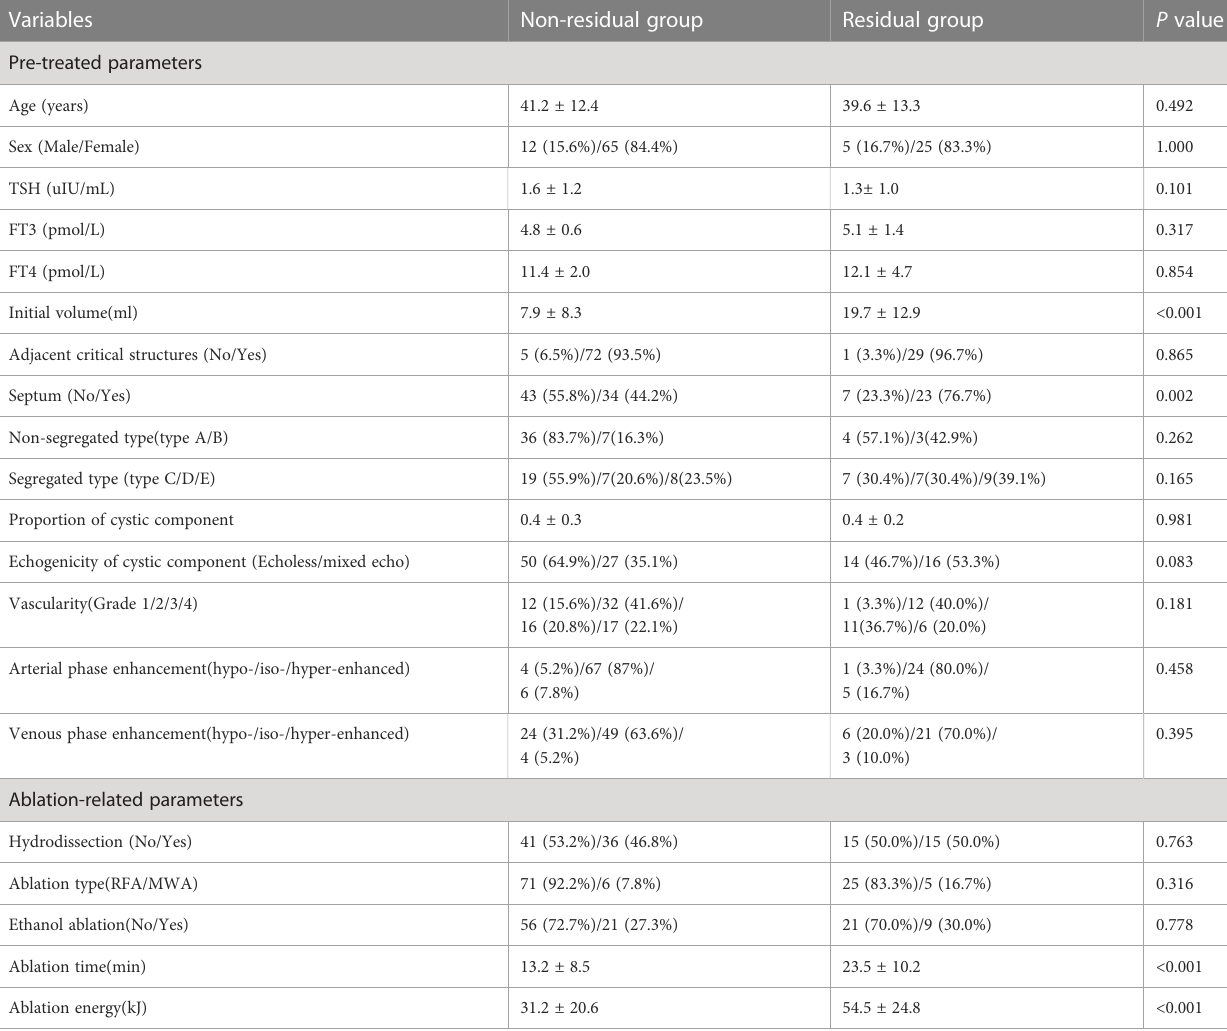
TABLE 2 The comparison between the non-residual and residual groups.